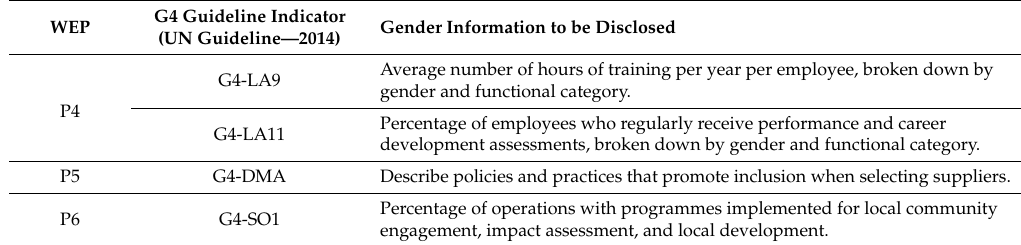
G4 Guideline Indicator (UN Guideline—2014)